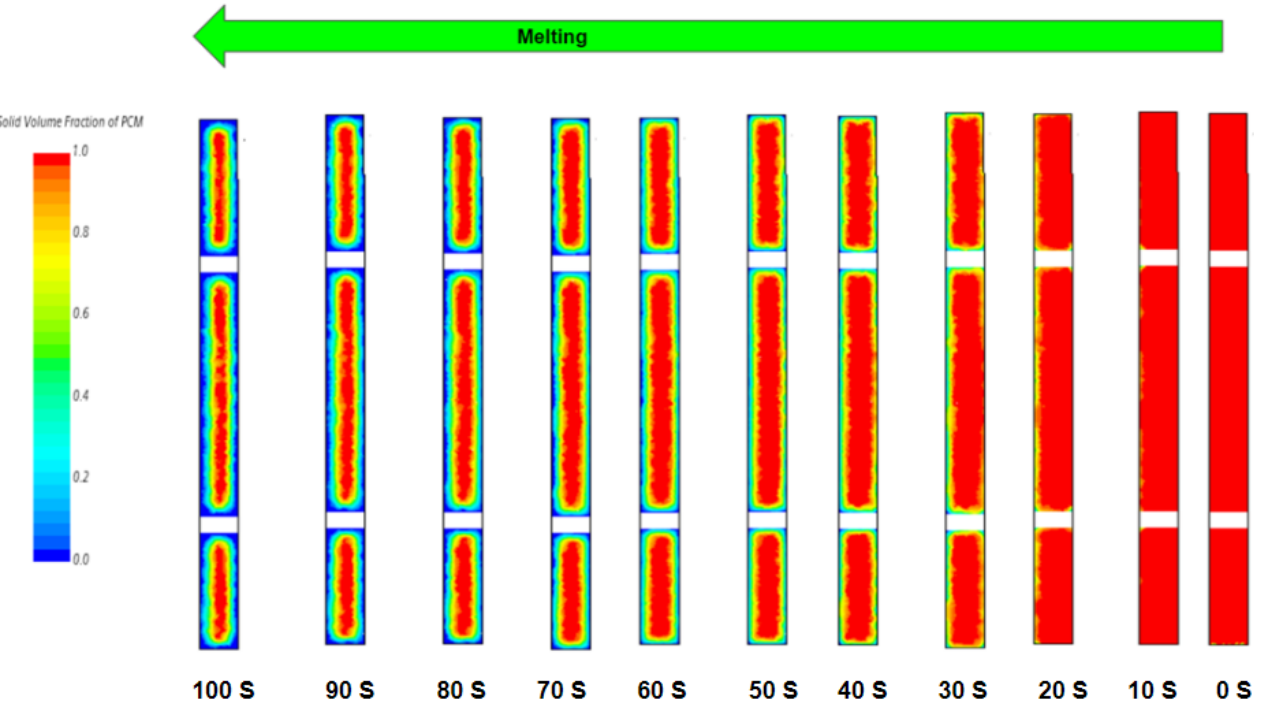
Figure 11. The volume change with function of time for no rib configuration.